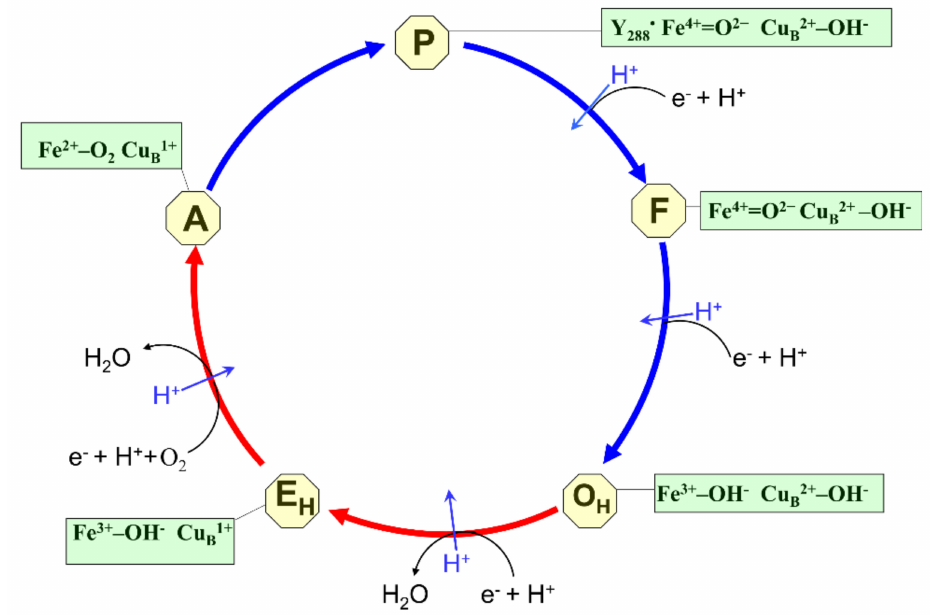
Figure 3. Catalytic cycle of the A family heme-copper oxidases. Shown are catalytic intermediates (O H , E H , A, P, F), and the structure of the binuclear heme-copper active site for each intermediate. The cycle can be divided into two parts, reductive and oxidative. The reductive part comprises transitions from O H to A. The oxidative part comprises transitions from A to O H . Pumped protons are shown by the blue